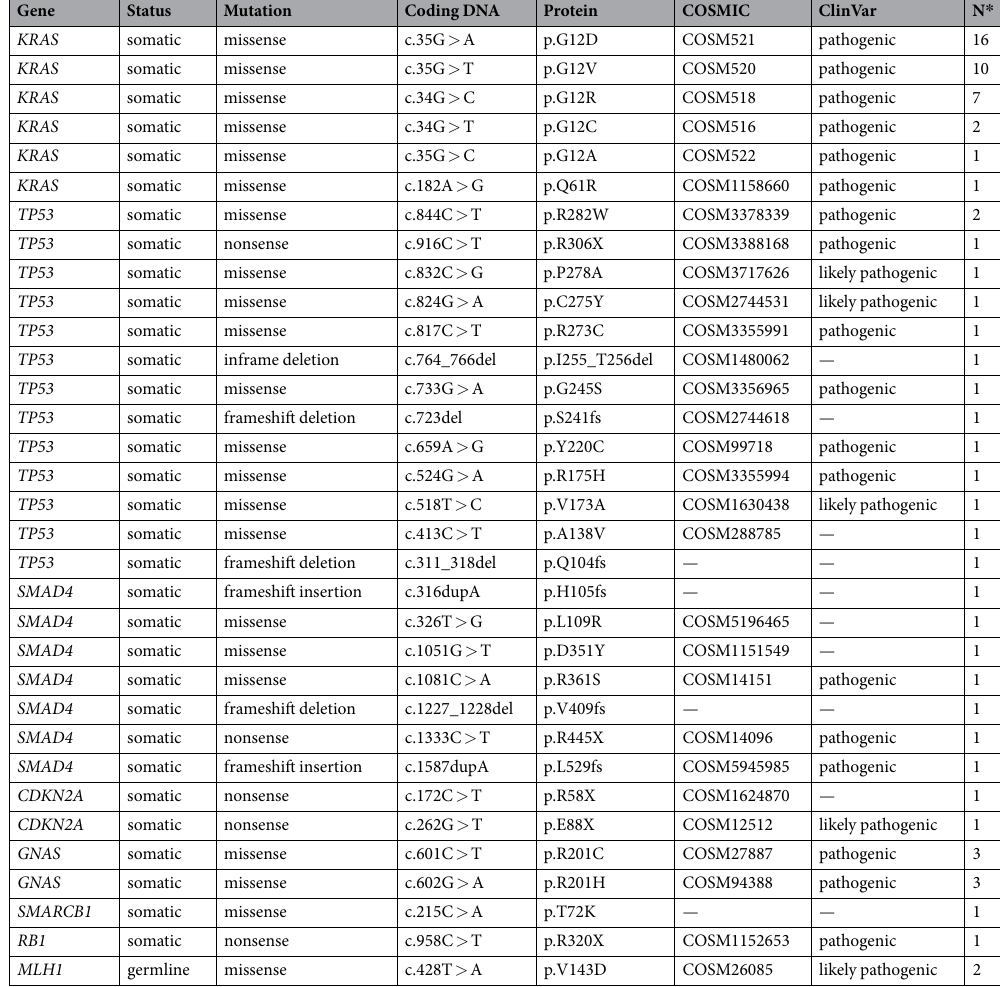
Table 2. Somatic and germline mutations in 50 cancer associated genes in pancreatic ductal adenocarcinoma. * N denotes number of